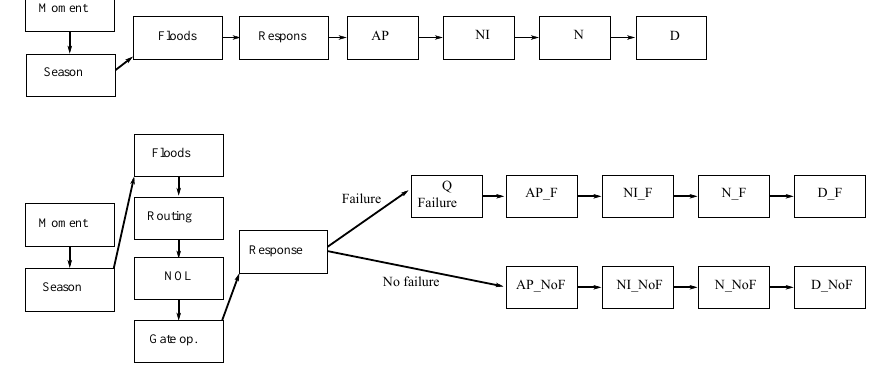
Figure 3. Generic risk model architecture: non-regulated river system (a) and regulated river system (b) .